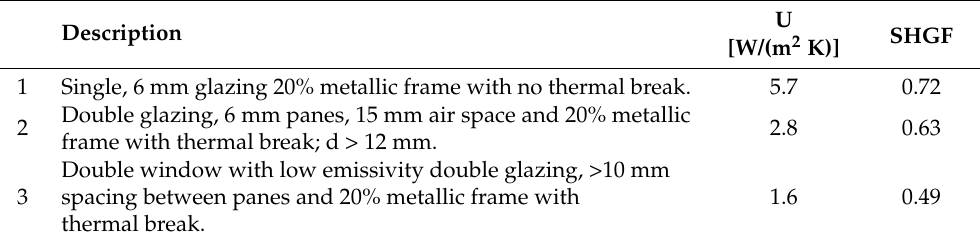
Table 3. Window properties selected